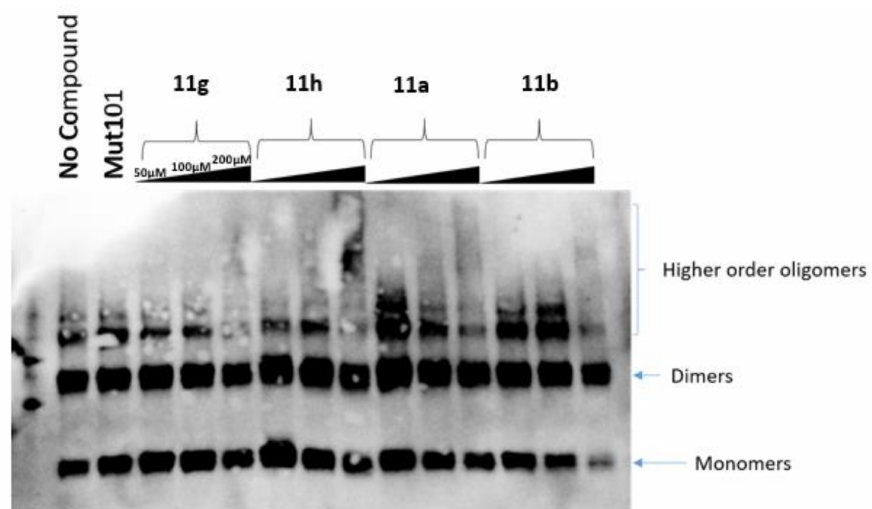
Figure 5. Western blot illustration of the multimerization caused by tested compounds. Compounds 11a , 11b , 11g , and 11h were selected for multimerization studies. Compounds were tested at 50 µ M, 100 µ M, and 200 µ M. MUT101 was included as a control and tested at 50 µ M only. Between the no-compound control and MUT101, an increase of higher order IN forms is noticed. An increase in higher order IN oligomers is most pronounced in compounds 11a , 11b , and 11h and the equilibrium shifts to higher order forms as a factor of compound